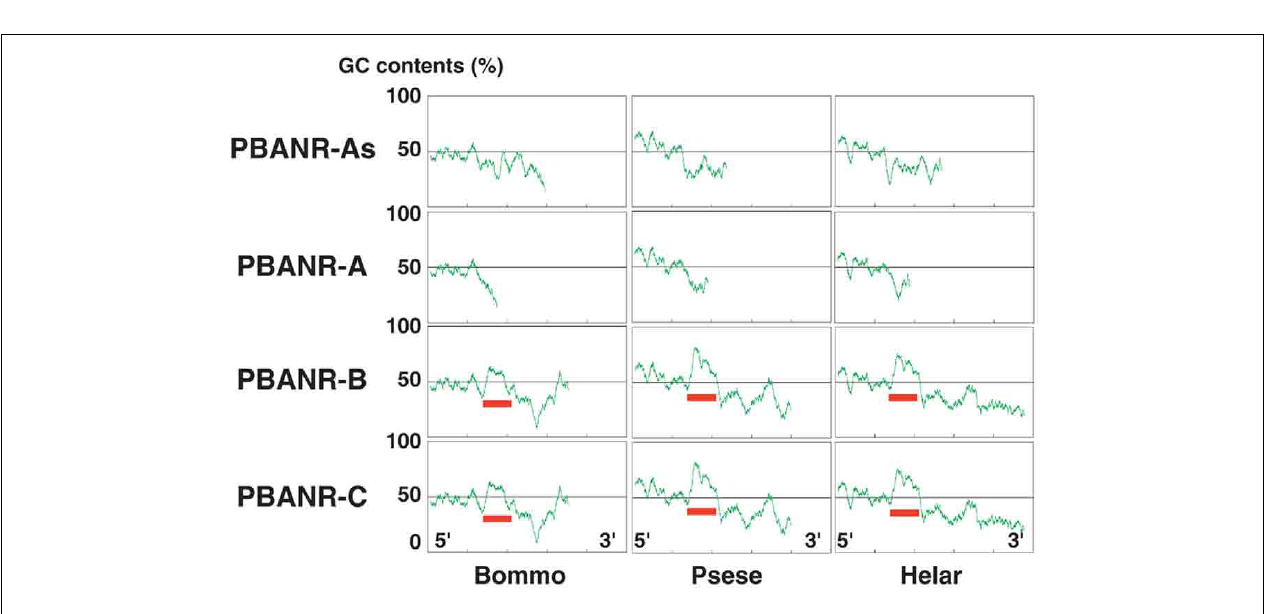
armigera was calculated using 100 base windows over a range of 700 bases. Red bars indicate the ∼ 300-nt coding sequence unique to the PBANR-B and -C